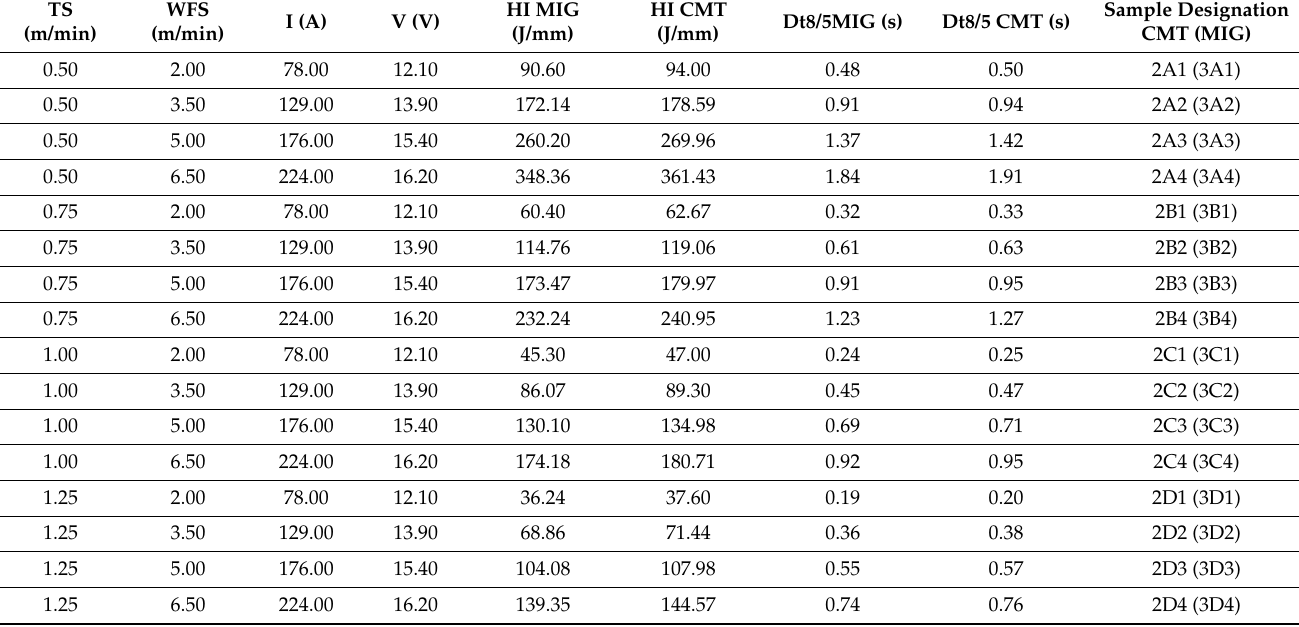
Table 2. Parameter settings and calculated values associated with each procesing